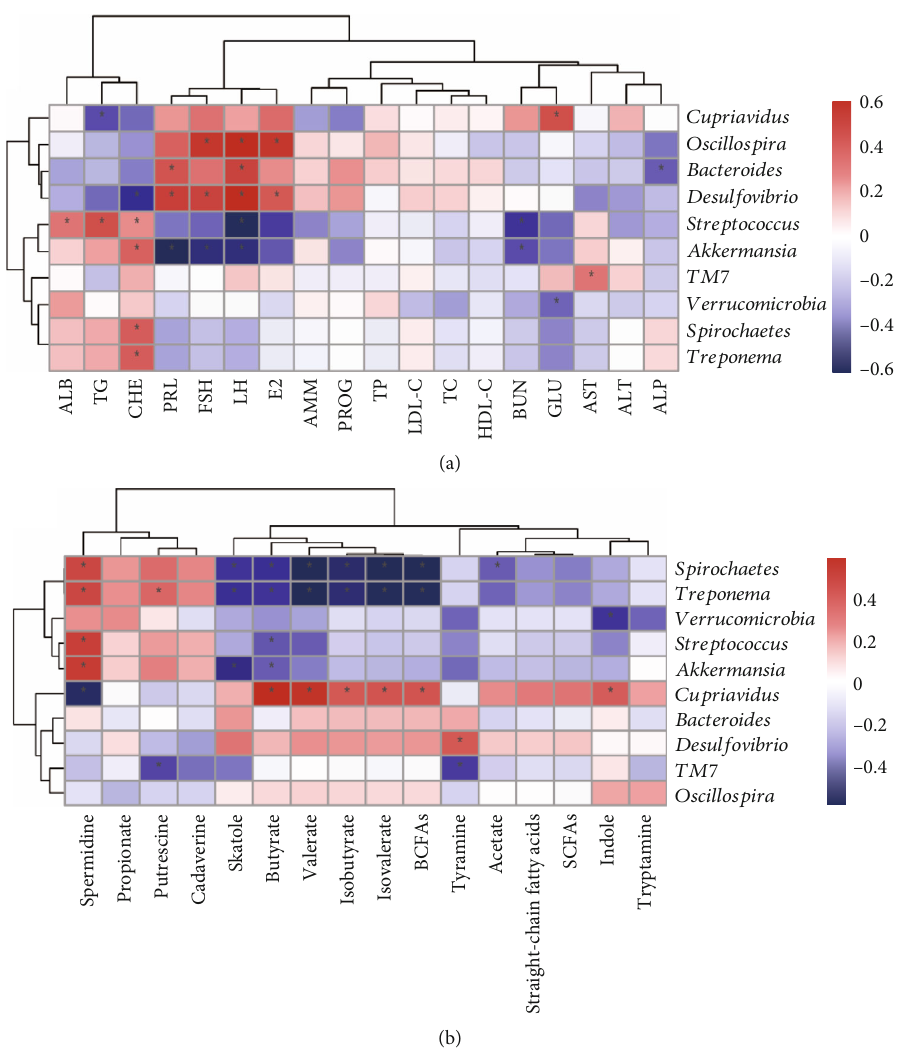
Figure 6: Correlations between the discrepant fecal microbiota and metabolite levels of sows. The plasma parameters (a) and fecal metabolites (b) are presented to be correlated with gut microbiota, respectively. Spearman correlations were used, and ∗ means the correlation signi fi cant. PRL: prolactin; LH: luteinizing hormone; FSH: follicle-stimulating hormone; PROG: progesterone; E